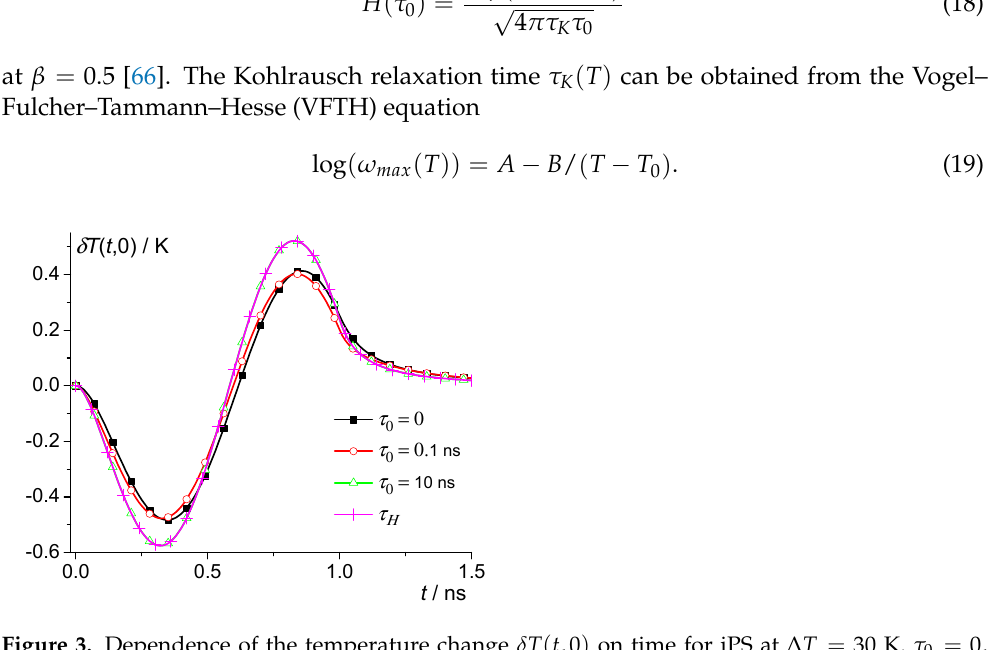
Figure 3. Dependence of the temperature change δ T ( t ,0 ) on time for iPS at ∆ T = 30 K. τ 0 = 0, 0.1 ns, and 10 ns—squares, circles, and triangles; crosses are the result of averaging δ T over the distribution H ( τ 0 ) .